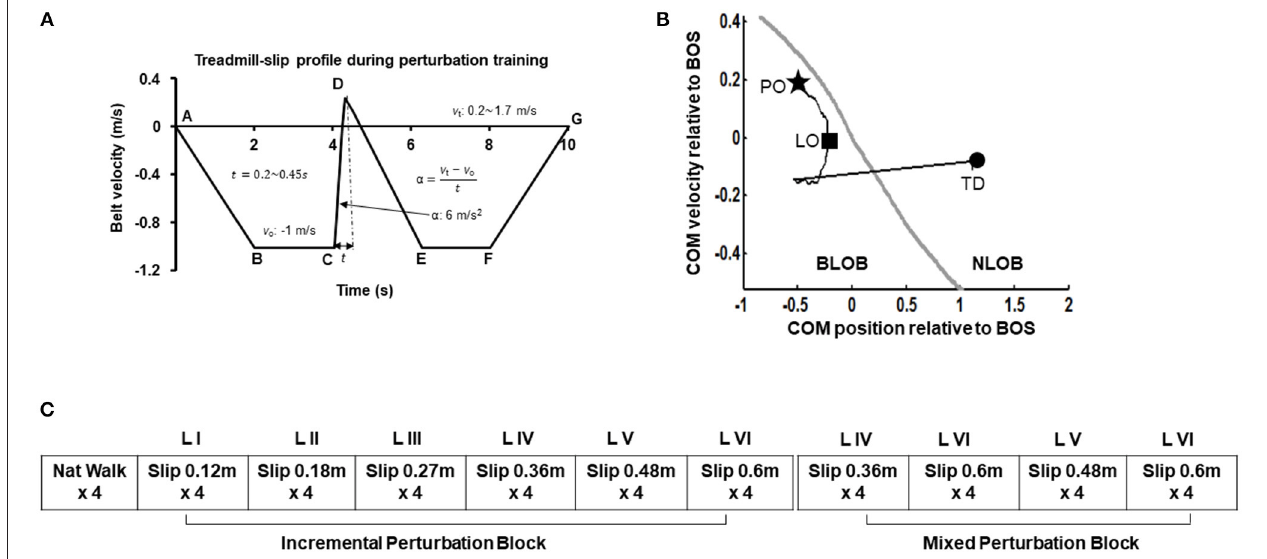
FIGURE 2 | (A) Treadmill-slip perturbation training profile of level III perturbation intensity with an acceleration of 6 m/s 2 at constant belt velocity of 1 m/s, and perturbation displacement and duration of 0.27m and 0.3s, respectively. Part A signifies the time instant at which the treadmill belt starts moving backwards and participant initiates walking. The treadmill belt backward velocity ramps up to 1 m/s (A to B), followed by a phase of constant velocity equal to the normal gait speed − of healthy young adults ( 1 m/s) (B to C). Part C signifies the time instant at which treadmill belt movement reverses in the forward direction to initiate a slip-like ∼ perturbation. The treadmill belt suddenly accelerates at a rate of 6 m/s 2 (C to D), inducing a slip-like perturbation resulting in a backward loss of balance